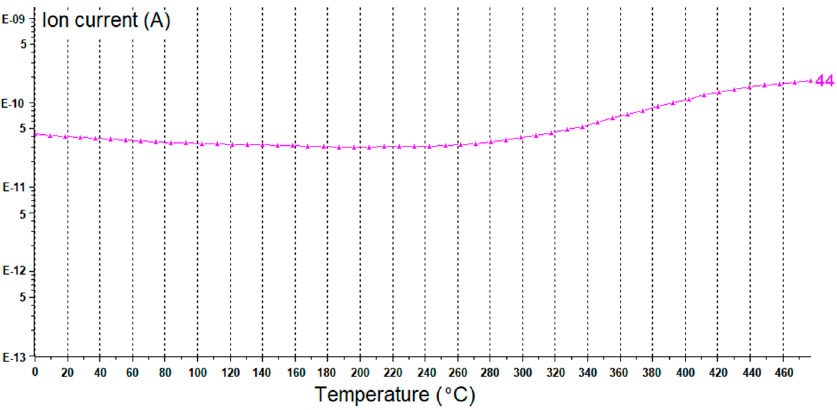
Figure 4. Mass spectrometry (MS) spectrum of unmodified nanosized CaO.